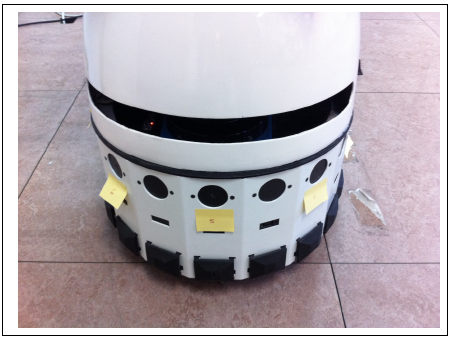
Figure 8. Microphones in the robot